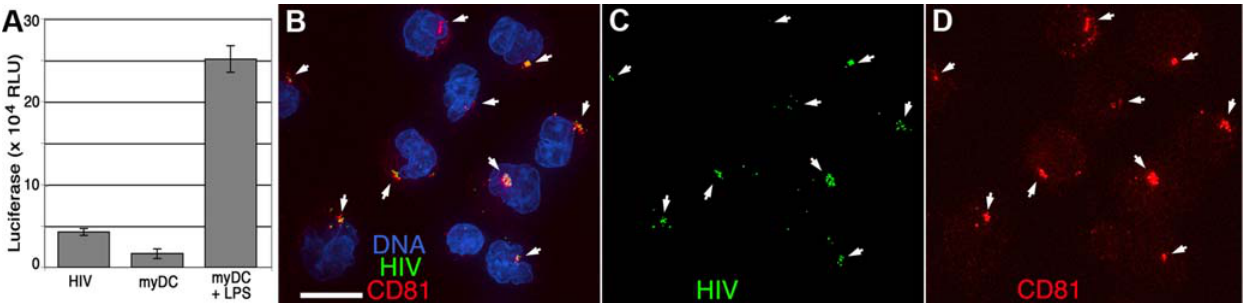
Figure 3. trans -infection and HIV sequestration in mature blood myeloid DCs. BDCA-1–positive myDCs were purified from PBMCs and cultured for 14 h without or with LPS to induce maturation. Cells were incubated with HxB2 pseudotyped GFP-Vpr HIV (green) for 1 h, washed and cultured for 1 h, then co-cultured with LuSIV cells, an HIV-LTR-luciferase indicator T cell line, or plated onto coverslips and prepared for microscopy. (A) LuSIV cells were assayed for luciferase activity 40 h later. HIV, cell-free input virus. Bars are the mean of triplicates 6 standard deviation. (B–D) Fixed, LPS-mature myDCs were stained for CD81 (red) and DNA (blue). Images are 3-D–rendered whole-cell volumes. Merged (B) and separated signals (C,D) are shown; arrows denote concentrated HIV. Scale bar, 10 m